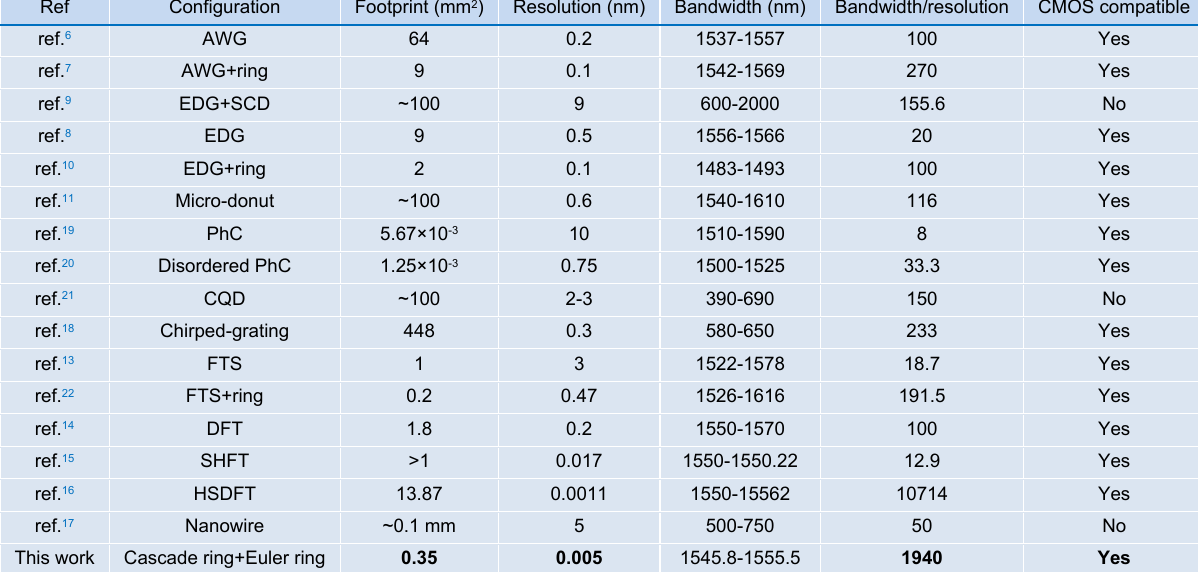
Table 1 | Comparison of some typical spectrometers